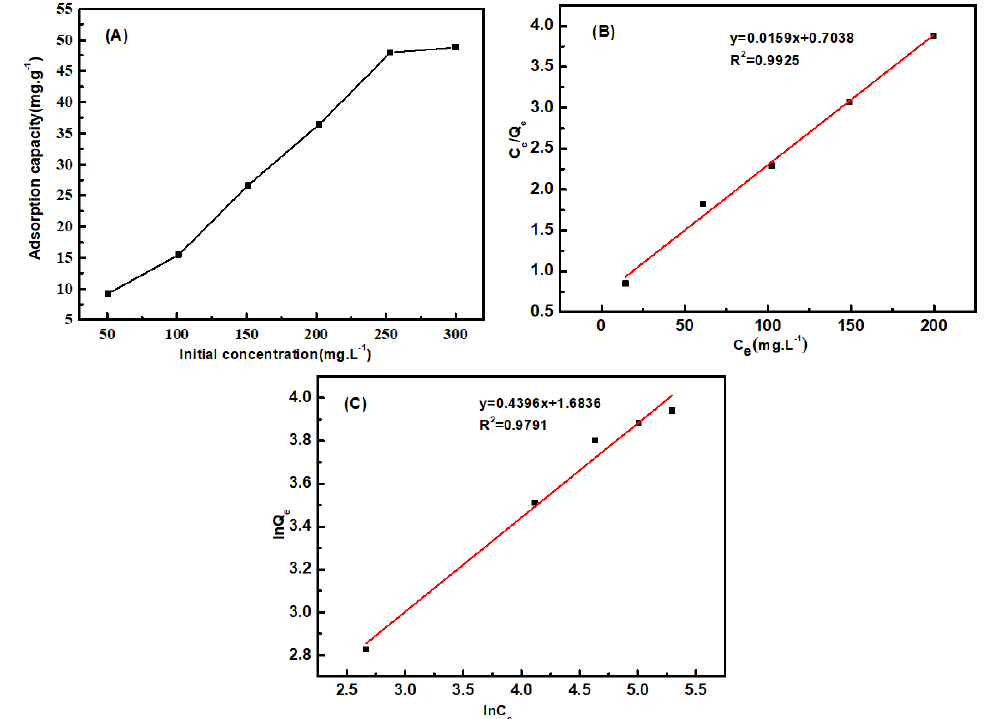
Figure 13. The effect of initial aniline concentration on adsorption capacity ( A ) and the linearized Langmuir( B ) and Freundlich ( C ) models. Table 2. Isotherm parameters.